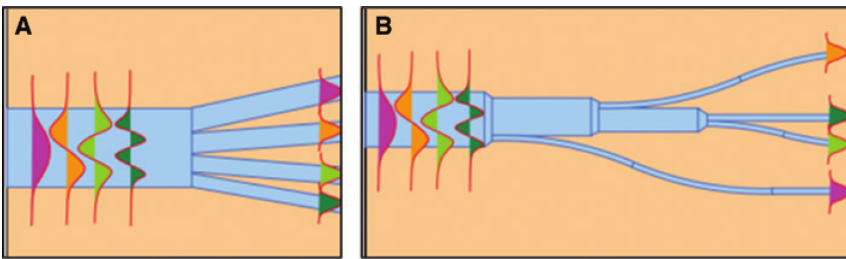
Figure 3: On-chip mode (de)multiplexers based on the mode evolution in an adiabatic waveguide structure. (A) An adiabatic Y-junction cascaded in parallel [43]. (B) An adiabatic Y-junction cascaded in series